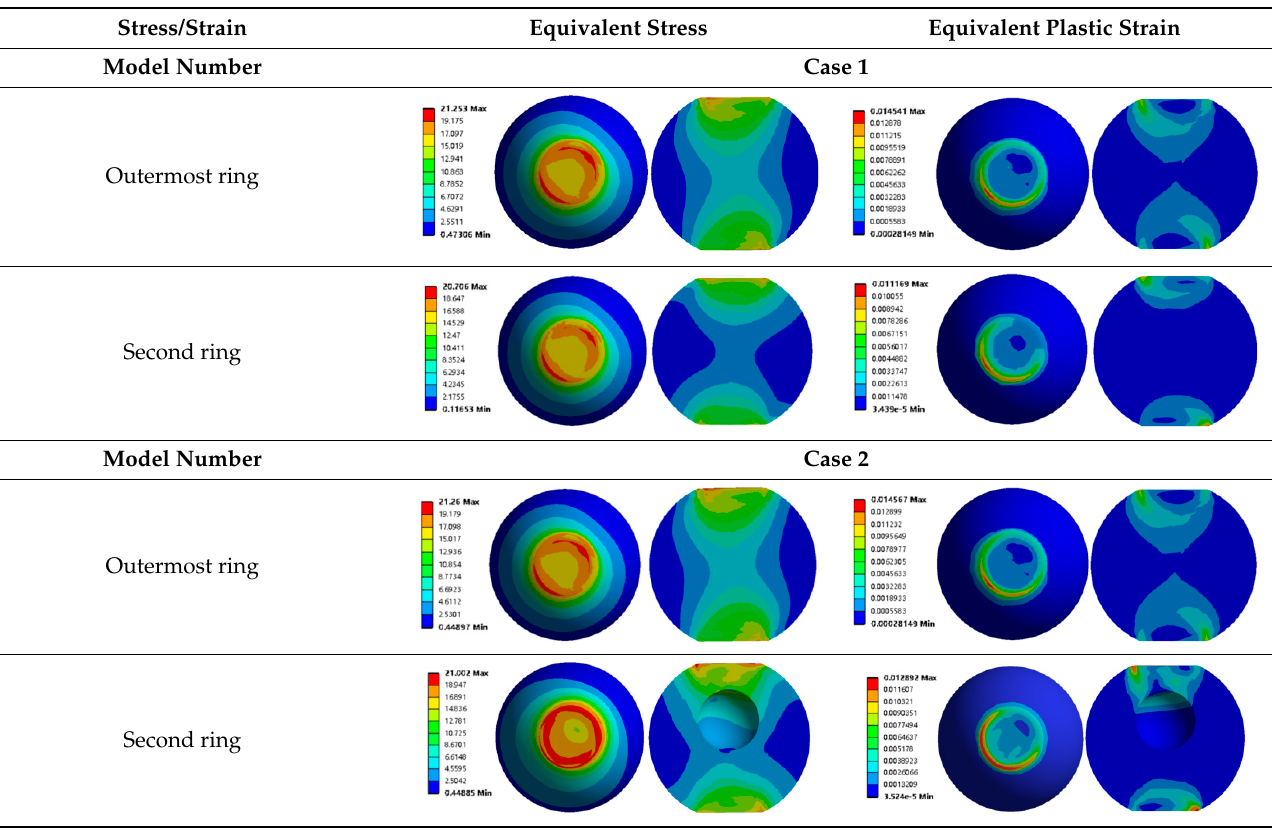
Figure 9. According to formulas 1 and 2, the fatigue life of the two was also equivalent.